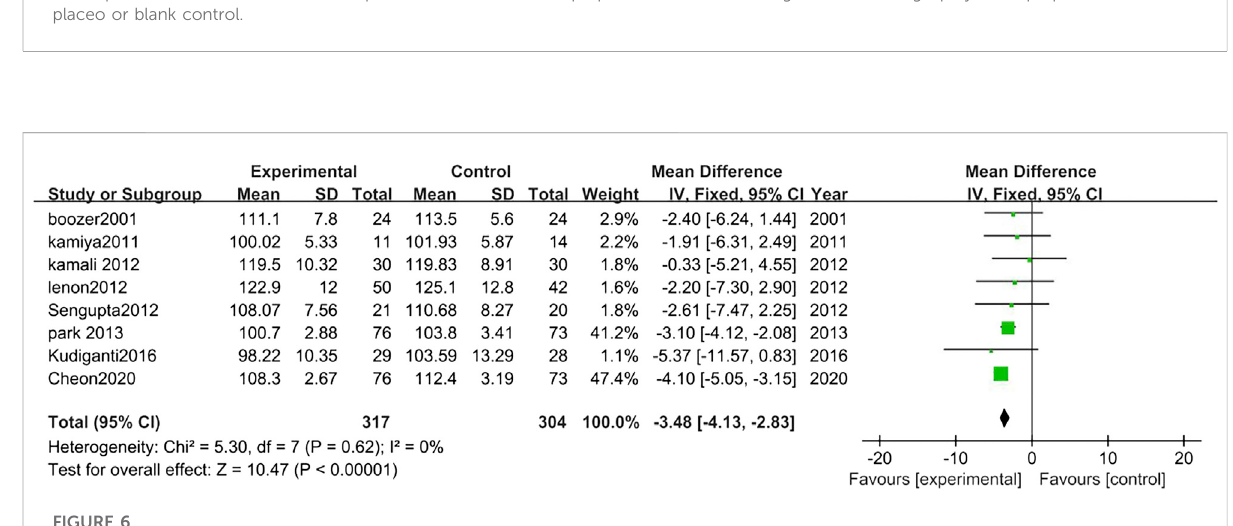
The results of the other eight studies: SBP: MD = − 5.27, 95%